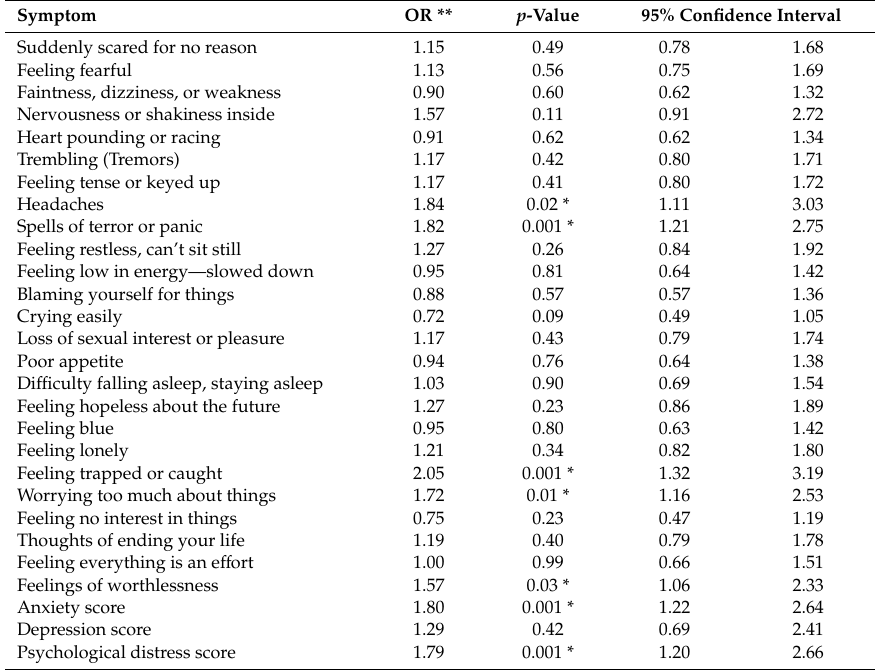
Table 4. The association between high caffeine intake ( > 400 mg / day) and symptoms of the study participants. Symptom OR ** p -Value 95% Confidence Interval Suddenly scared for no reason